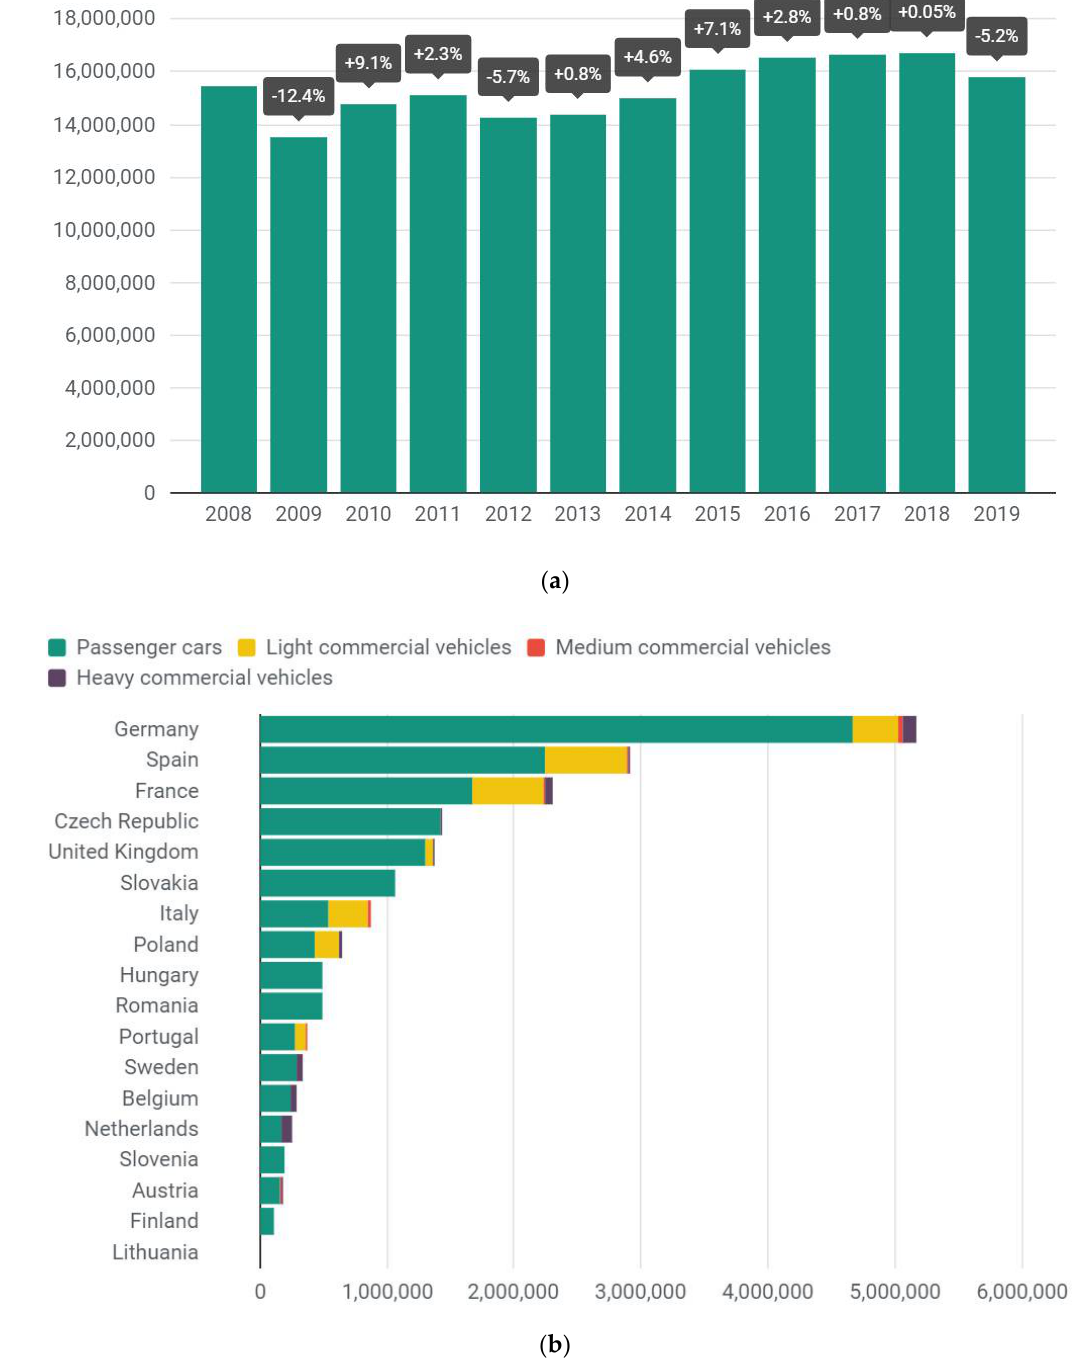
Figure 2. ( a ) Export of American vehicles from EU production of passenger cars, ( b ) EU production of motor vehicles by countries [16].